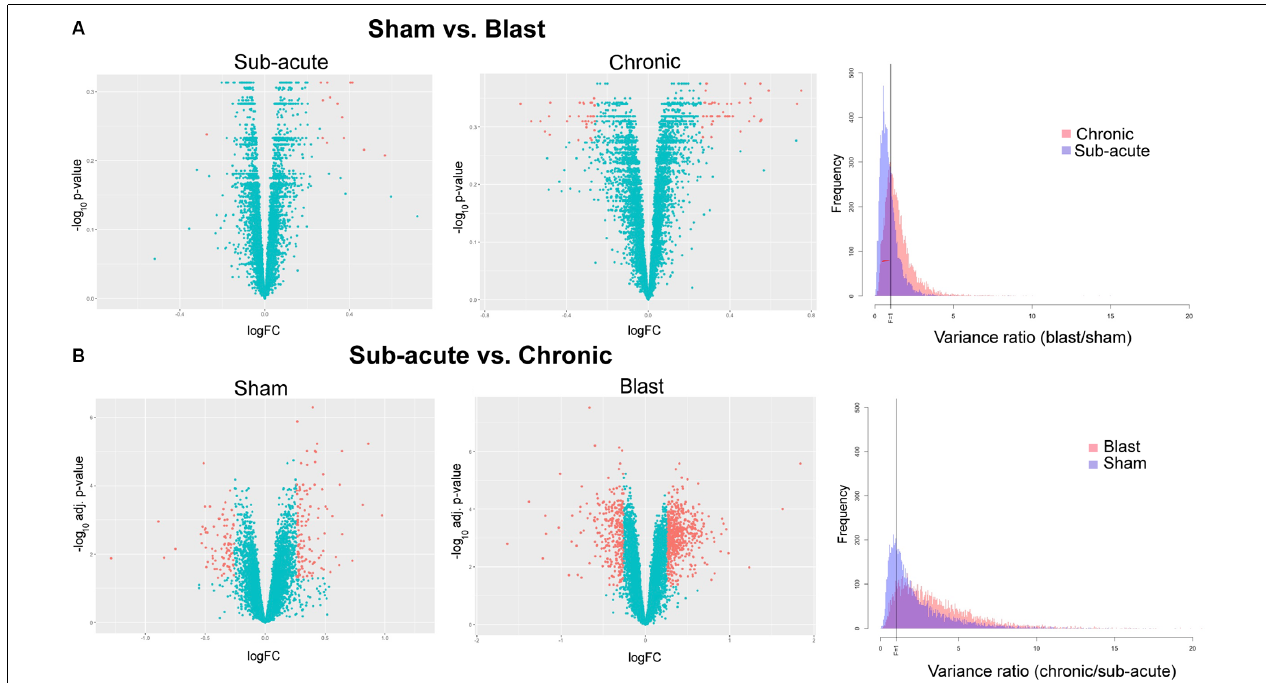
FIGURE 4 | Differentially expressed genes and variance ratios. Volcano plots depicting differentially expressed genes (orange; |logFC| ≥ 1.2 and raw or adjusted p -values ≤ 0.05) between (A) blast vs. sham animals within the sub-acute and chronic cohorts and (B) chronic vs. sub-acute time points with the sham and blast groups. Histograms depicting variance ratios to demonstrate variability within gene expression are also